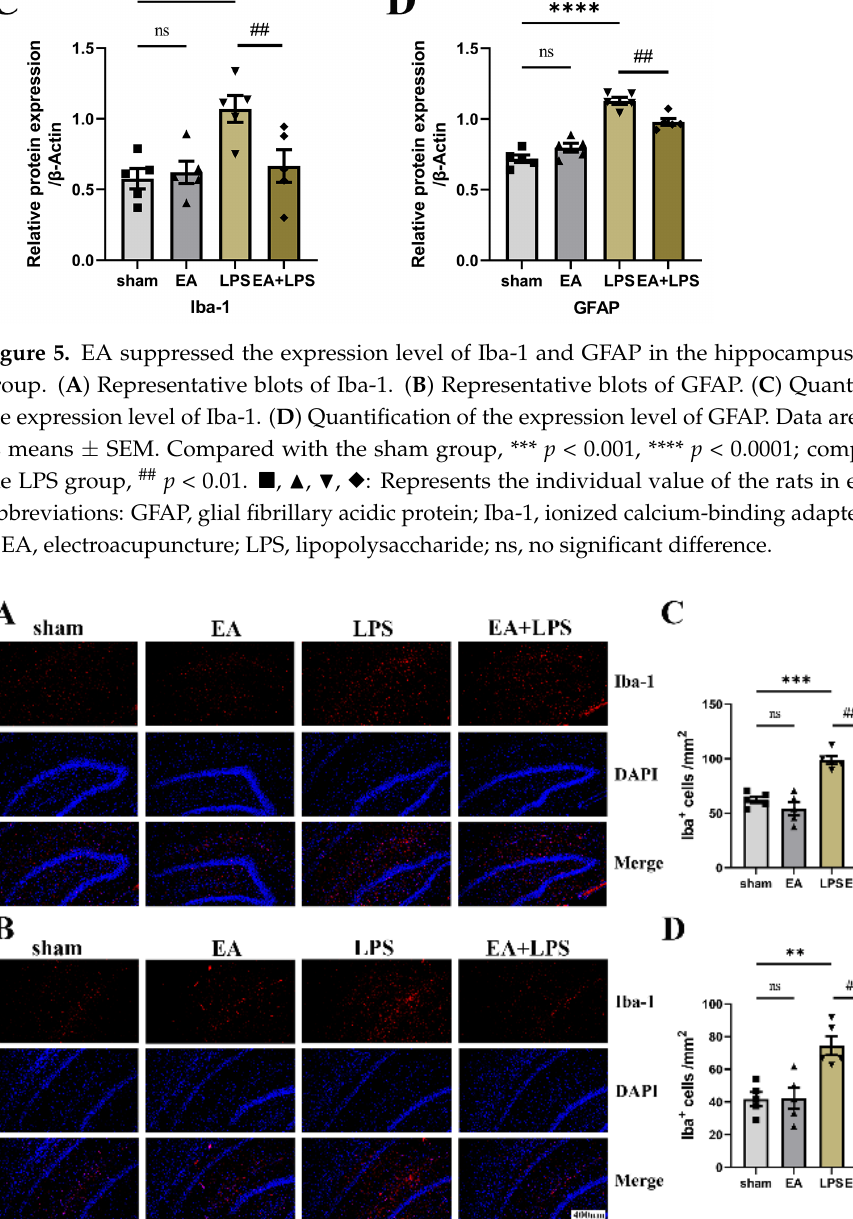
Figure 6. EA alleviated the activation of microglia in the DG and CA1 regions, n = 5 per group. ( A ) Representative IF images of activated microglia in the DG region. ( B ) Representative IF images of activated microglia in the CA1 region. ( C ) The statistical results of Iba-1 + cell count in the DG region. ( D ) The statistical results of Iba-1 + cell count in the CA1 region. Magnification: 20×, scale bar = 400 μ m. Data are presented as means ± SEM. Compared with the control group, ** p < 0.01, *** p < 0.001; compared with the LPS group, ## p < 0.01, # p < 0.05. , , , : Represents the individual value of the rats in each group. Abbreviations: DAPI, 4’,6-diamidino-2-phenylindole; DG, dentate gyrus; Iba-1, ionized calcium-binding adapter molecule 1; EA, electroacupuncture; LPS, lipopolysaccharide; ns, no significant difference.